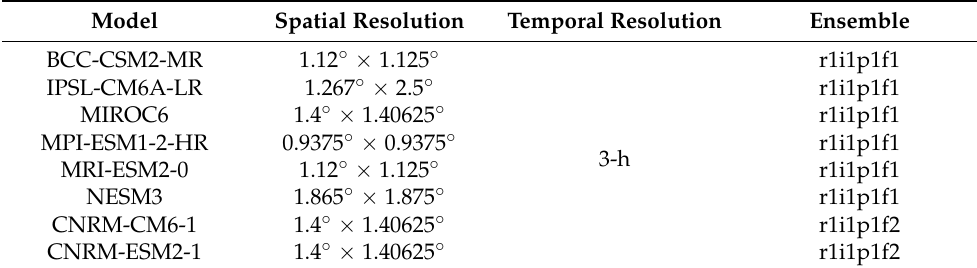
Table 1. CMIP6 GCMs with a dataset modelled over 3 h used in wind wave